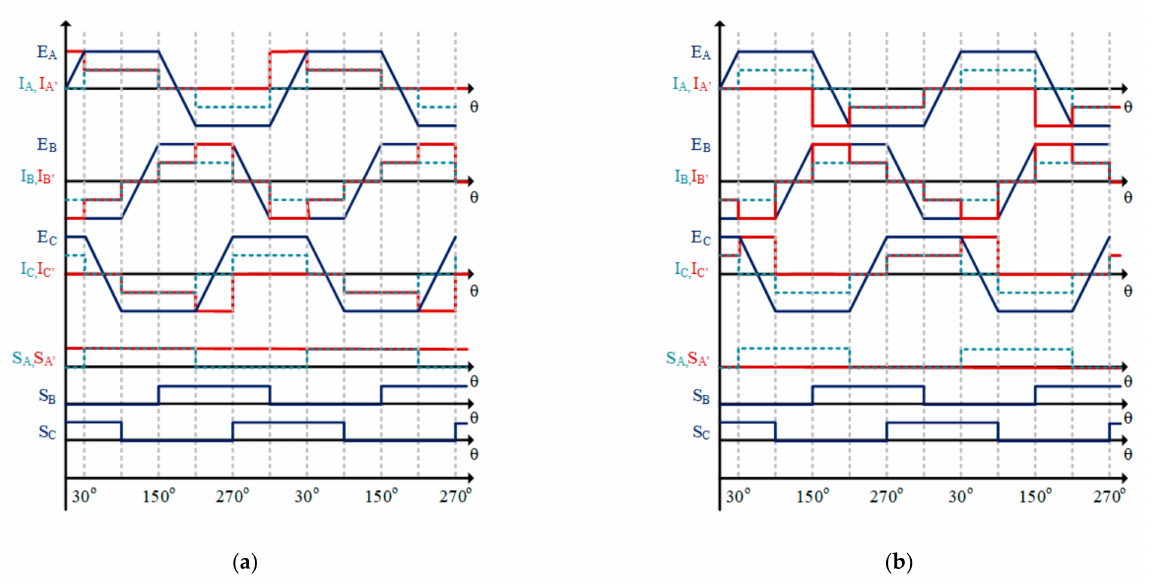
Figure 8. Comparison of ideal and resulting phase current waveforms according to the defective position sensor state. ( a ) Defective sensor A at high state; ( b ) Defective sensor A at low